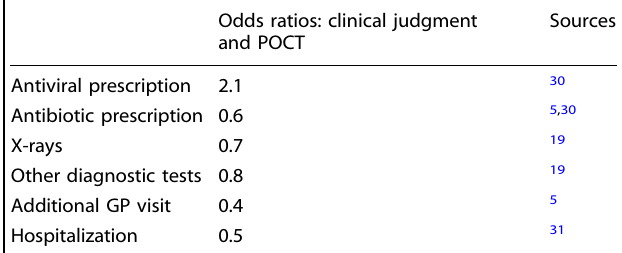
Table 3. Differences in probabilities for resource utilization comparing clinical judgment and POCT.